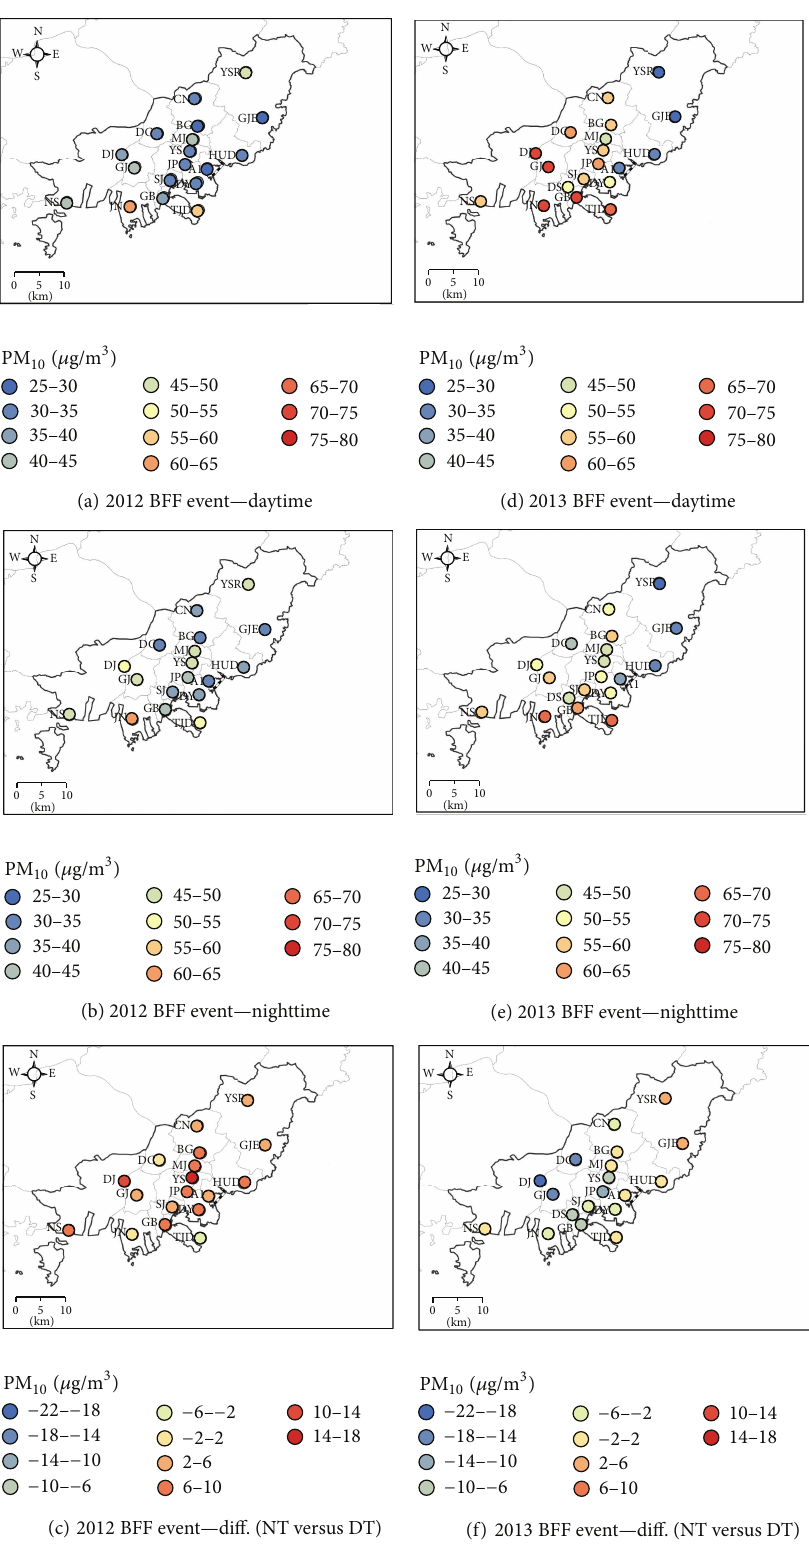
Figure 4: Distribution of daytime ((a) and (d)) and nighttime ((b) and (e)) PM 10 concentrations and concentration differences between nighttime and daytime ((c) and (f)) during the BFF event